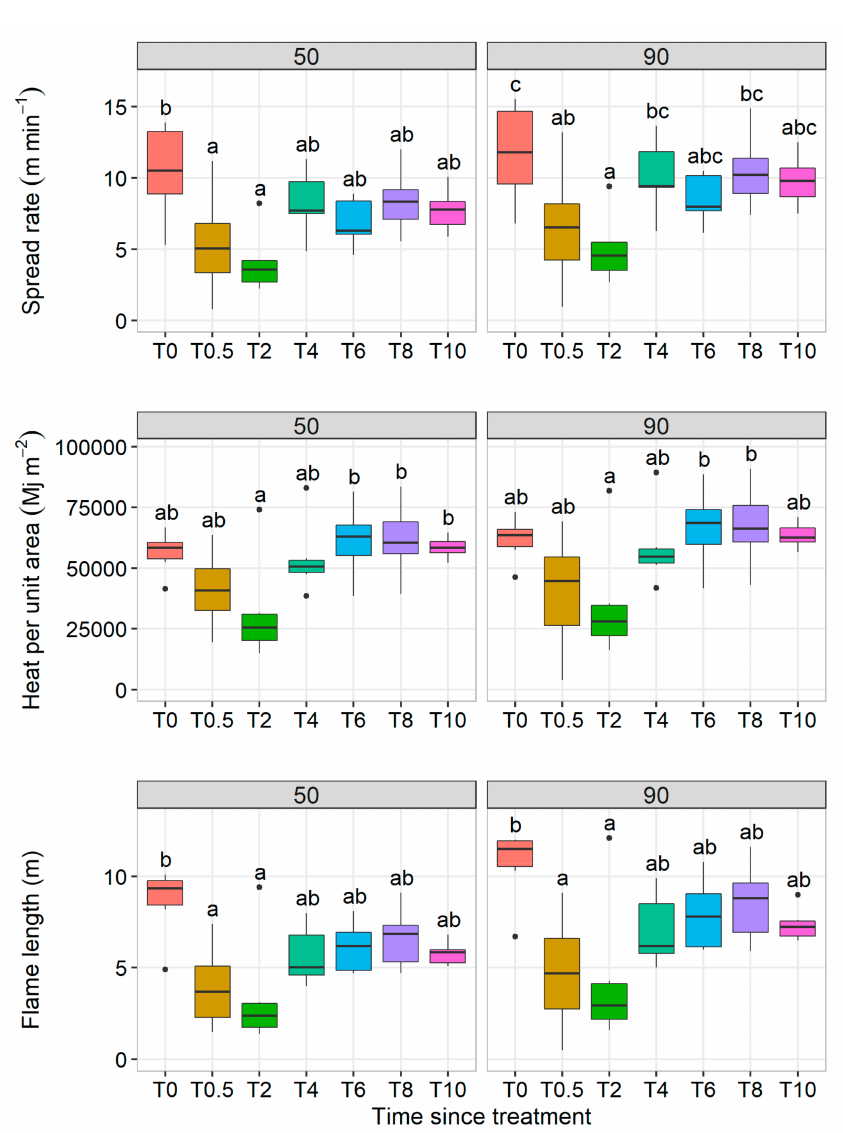
Figure 2. Fire behavior parameters for the stands depending on the time since treatment and weather scenarios. Means with same letter are not significantly different according to the HSD Tukey